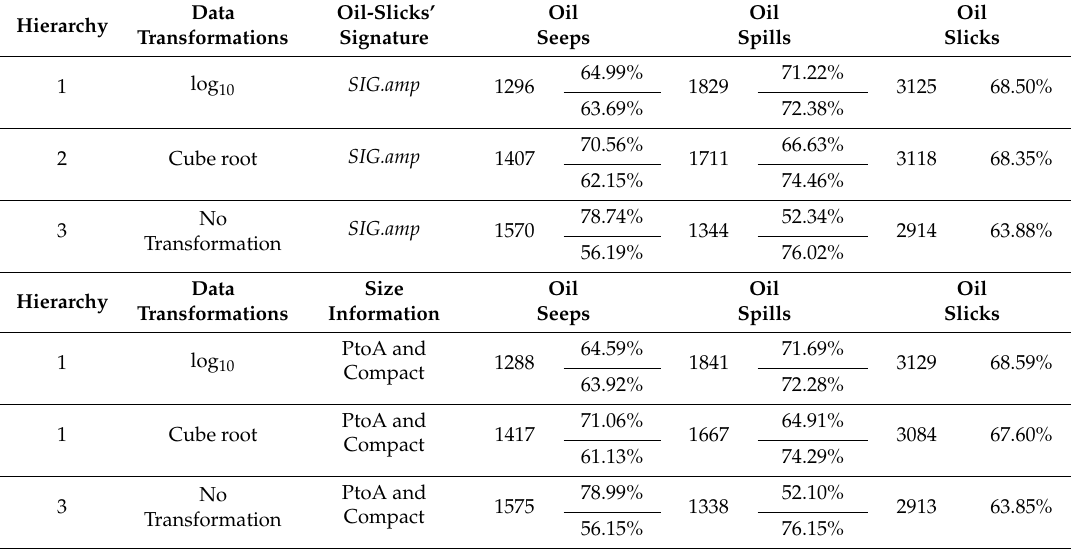
Table 7. Outcomes of the linear discriminant analyses (LDAs) from the first refined study [31,32]. Top: oil-slicks’ signature (SAR signature: sigma–naught with no despeckle filter— SIG.amp ). Bottom: size information (size only: PtoA and Compact). See also Tables